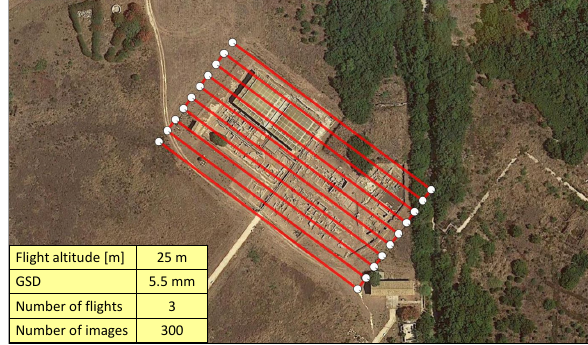
Figure 4. Flight specifications for the Insulae .